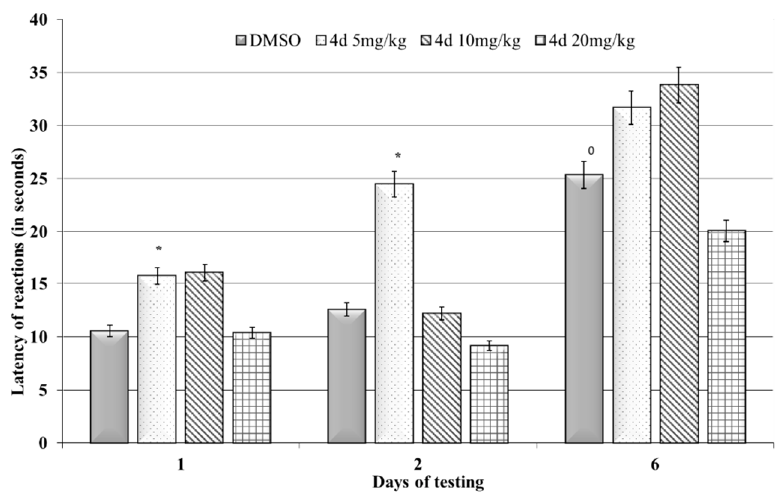
Figure 7. Effects of 4d on learning and memory processes in rats (step-down passive avoidance test); 0 p < 0.05 compared with day 1 control group; * p < 0.05 compared with the same-day control group.